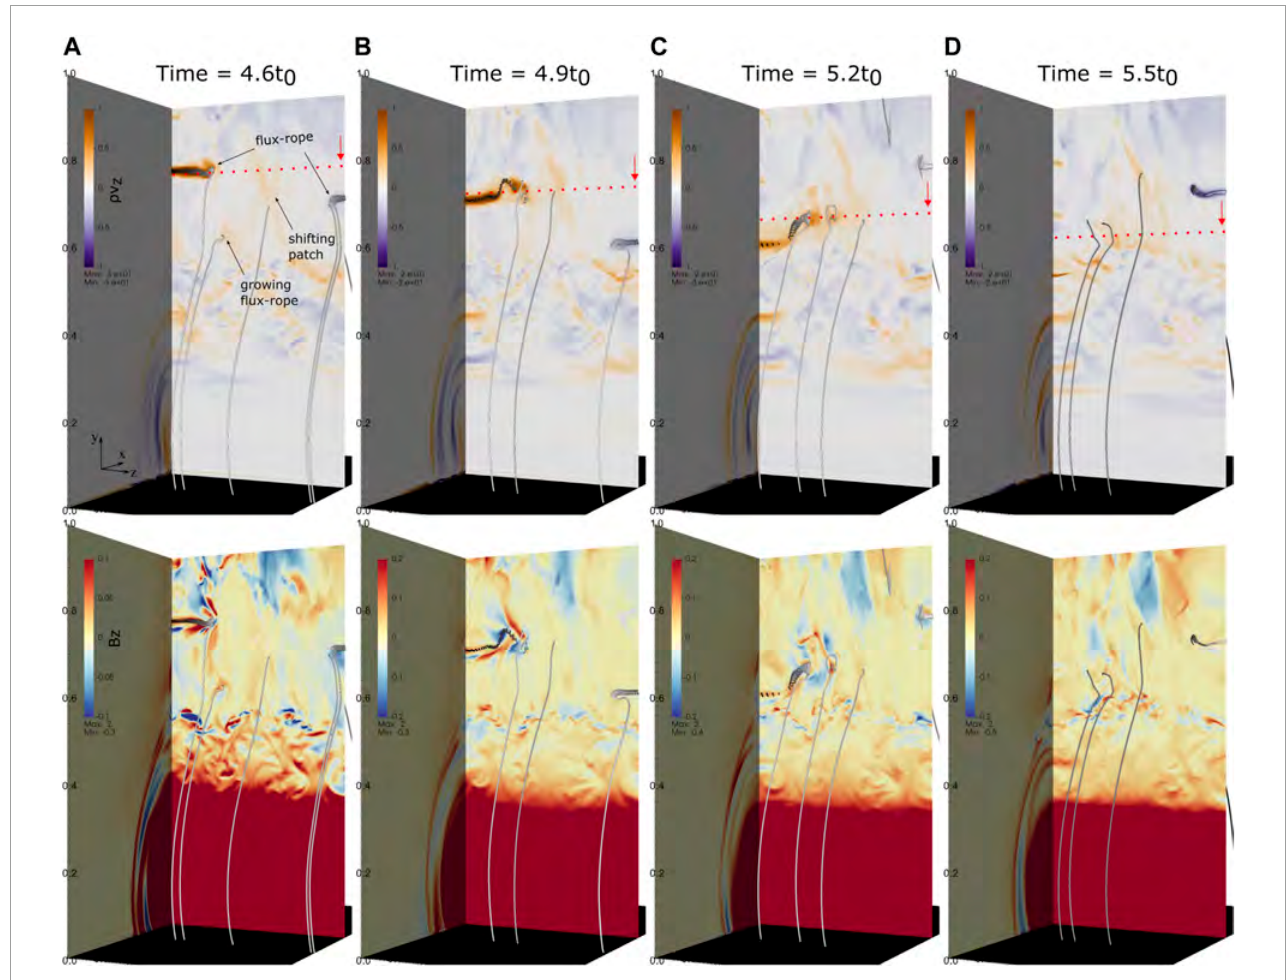
FIGURE 9 Distribution of momentum component ( ρ V z ) and magnetic component B z on the center plane ( x = 0 ) at different times. Panels (A–D) are for Time = 4.6, 4.9, 5.2, and 5.5 t 0 , respectively. The upper row is for ( ρ V z ) in which the gray tubes show magnetic field lines around the well-developed magnetic flux-ropes, the growing magnetic flux-rope, and shift-moving reconnection outflow patches in z − direction. The red dotted lines and arrows indicate the same heights annotated in Figure 8 . The low panels are for B z with the same magnetic field